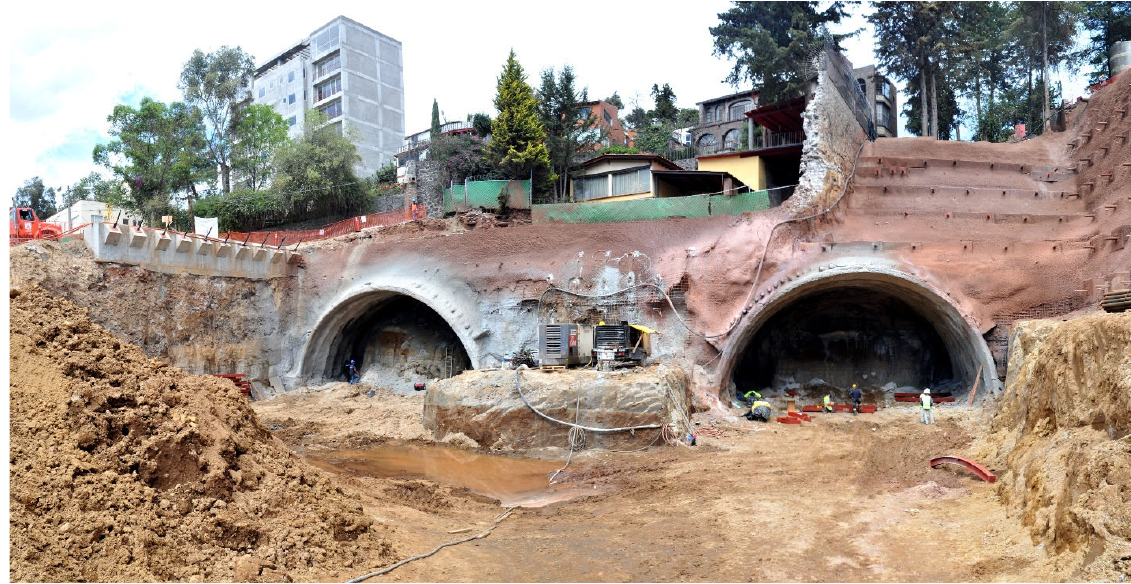
Figure 26. South Portal, where there was the least coverage (8 m).